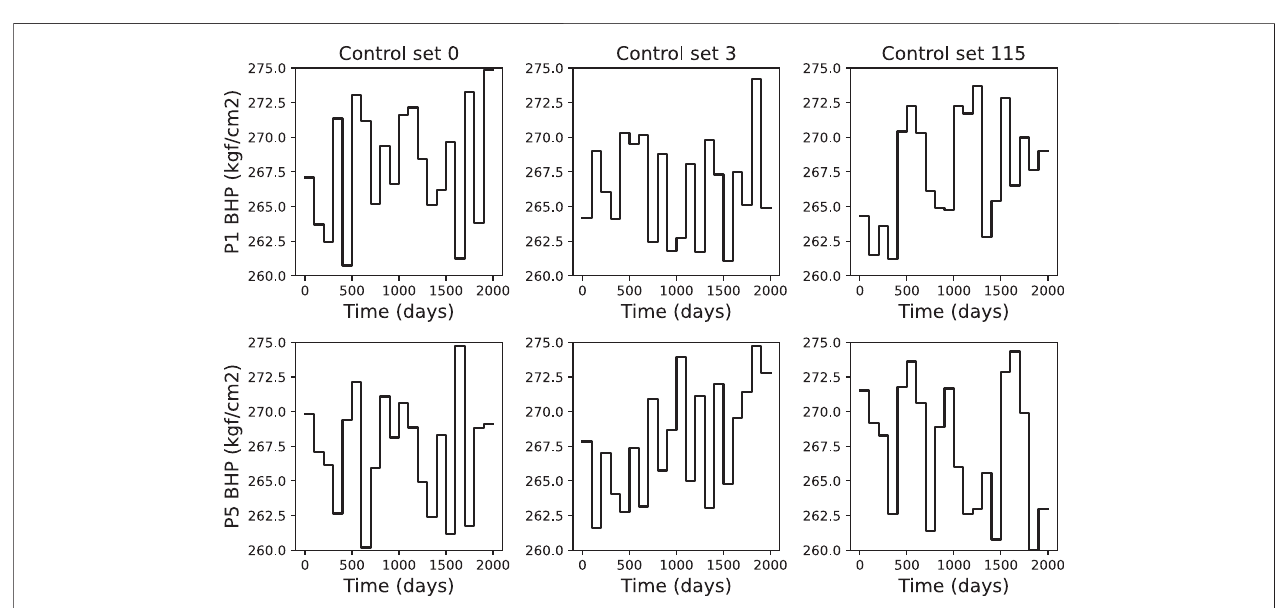
FIGURE 13 | Producers BHP controls examples for wells P1 ( fi rst row) and P5 (second row) where each column represents a control set.